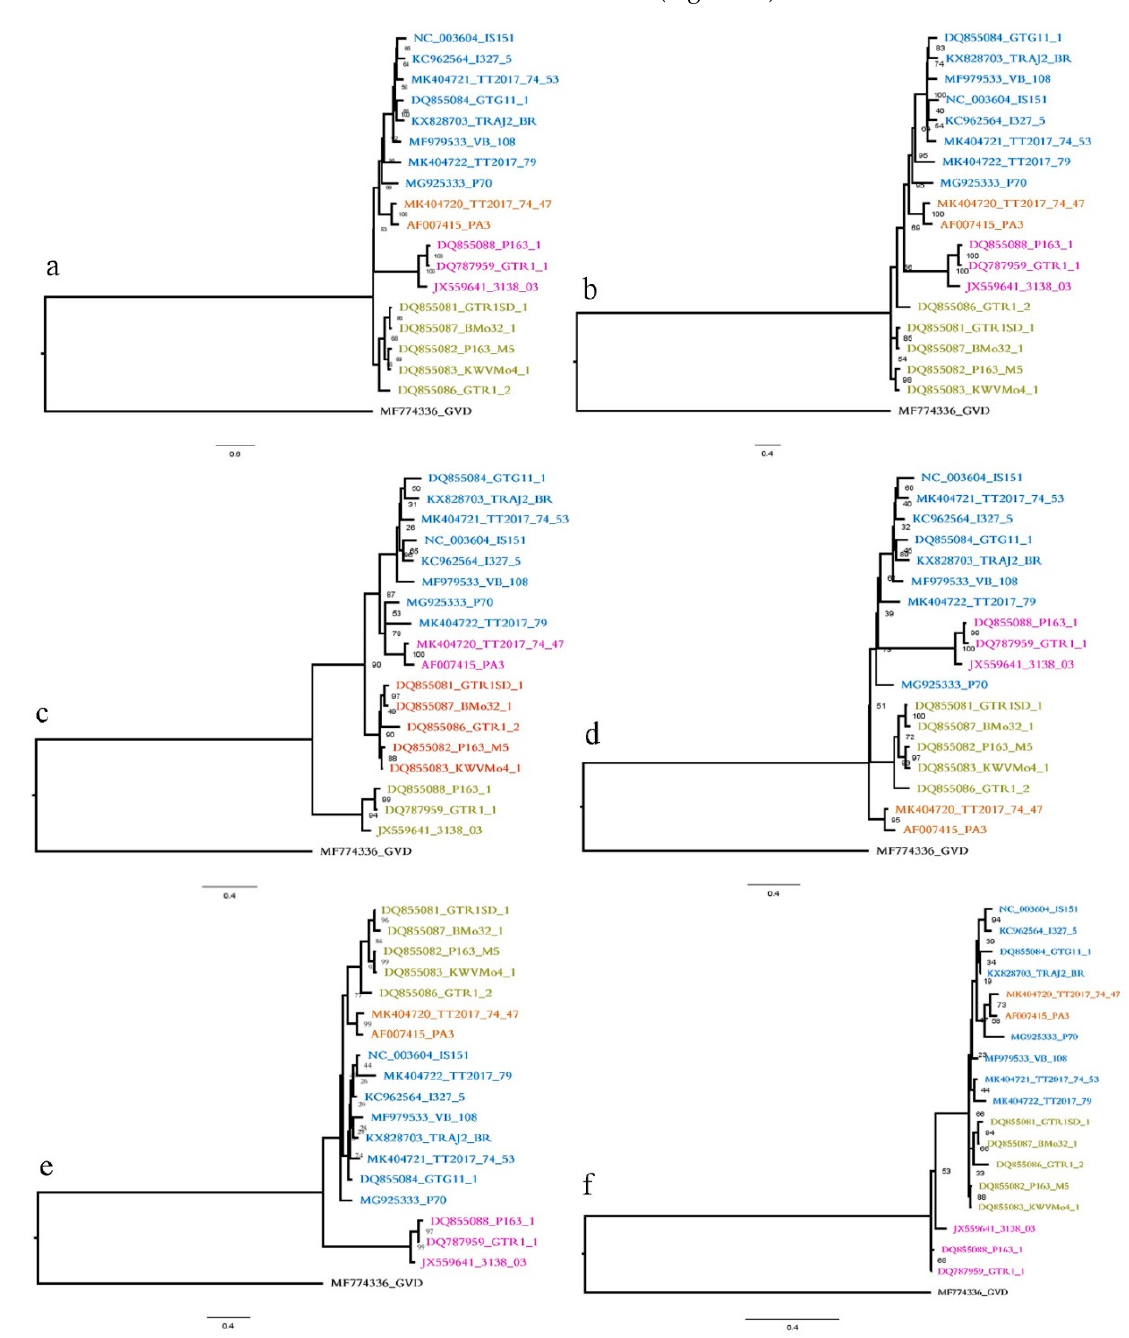
Figure 3. ML phylogenetic tree of ( a ) 18 terminals based on full genome sequences of all available GVA isolates and ( b ) 18 terminals based on ORF1, ( c ) ORF2, ( d ) ORF3, ( e ) ORF4, and ( f ) ORF5 sequences, all rooted by a GVD isolate. The classification is according to Alabi et al. [19]. Four clades, namely, I (blue), II (dark green), III (purple) and IV (brown) are shown.